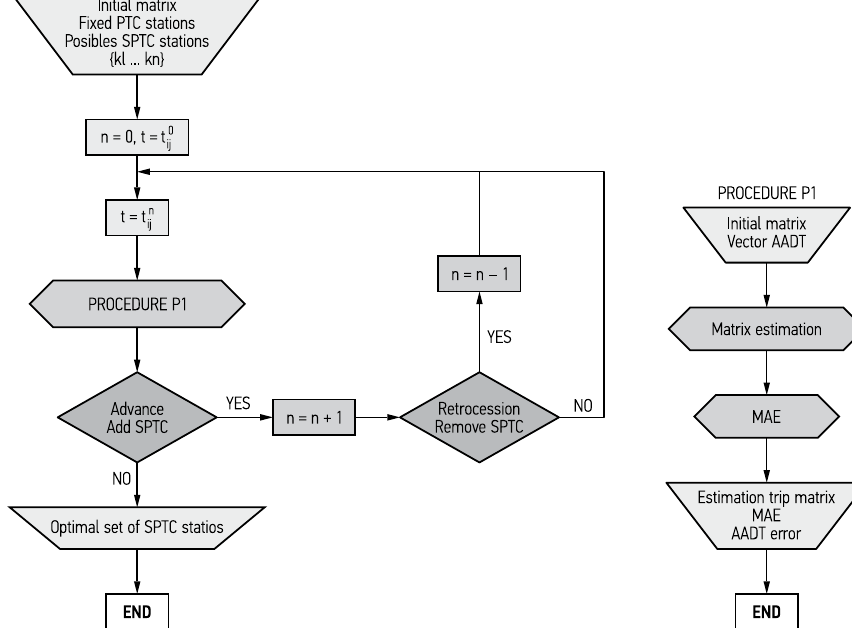
Fig. 1. Methodology for calculating the optimal number and location of counting